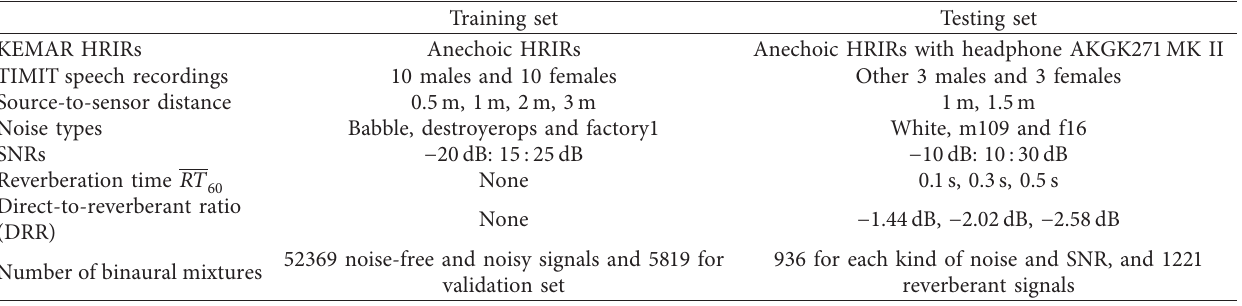
Figure 1: Schematic diagram of the multiscale dilated CNN. Table 1: Configuration of training and testing